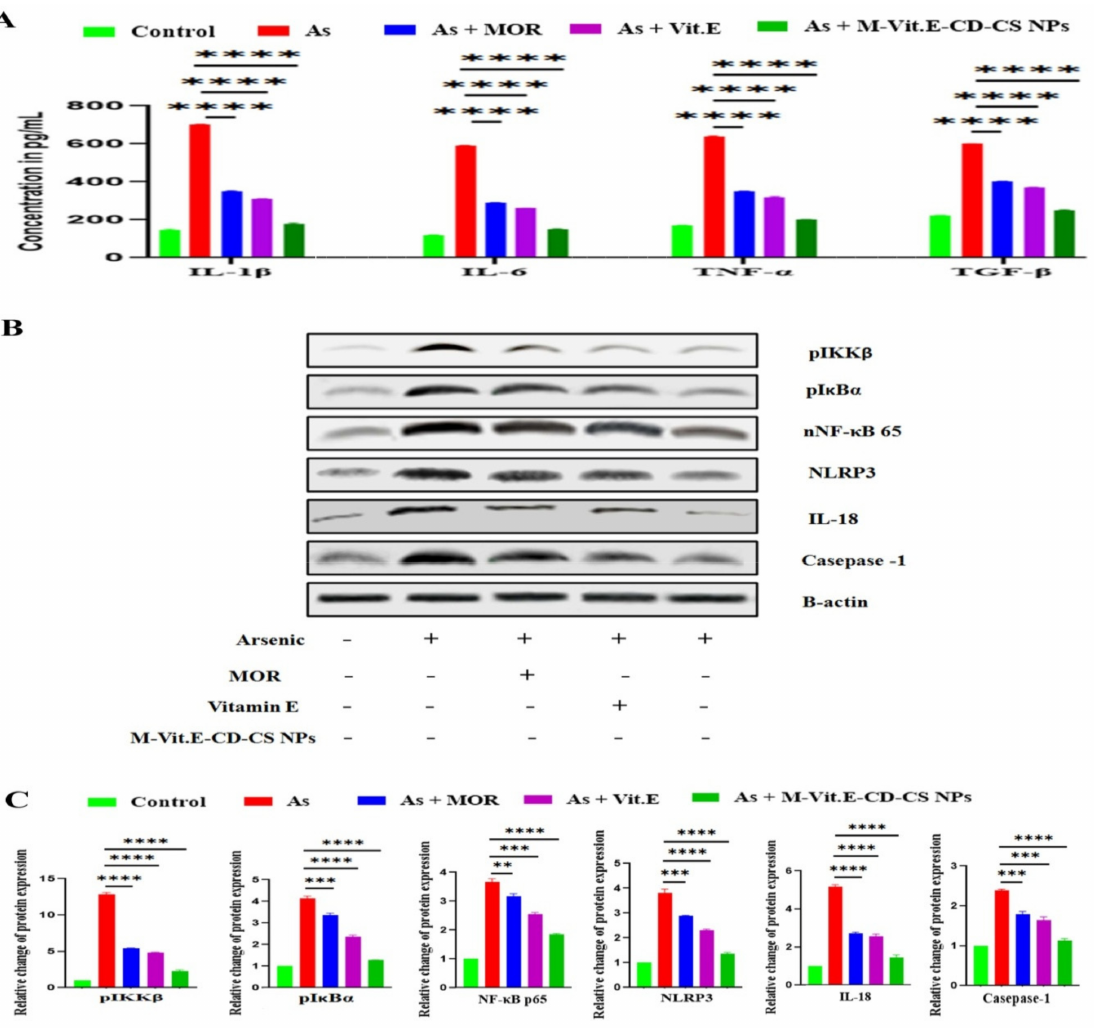
Figure 7. Effect of MOR, vitamin E, and M-Vit.E-CD-CS NPs on the level of ( A ) TNF- α , IL- β , IL-6, and TGF- β in the liver tissue lysate of arsenic challenged mice as seen in ELISA analysis. Data are one of the three representative experiments ± SD (**** p , 0.0001). ( B ) the effect of MOR, vitamin E, and M-Vit.E-CD-CS NPs on protein expression of nuclear NF-kBp65, NLRP3, Caspase-1, and IL-18 (western blot analysis). ( C ) Relative change of protein expression of the respective protein with respect to β -actin (** p , 0.01, *** p , 0.001, **** p ,